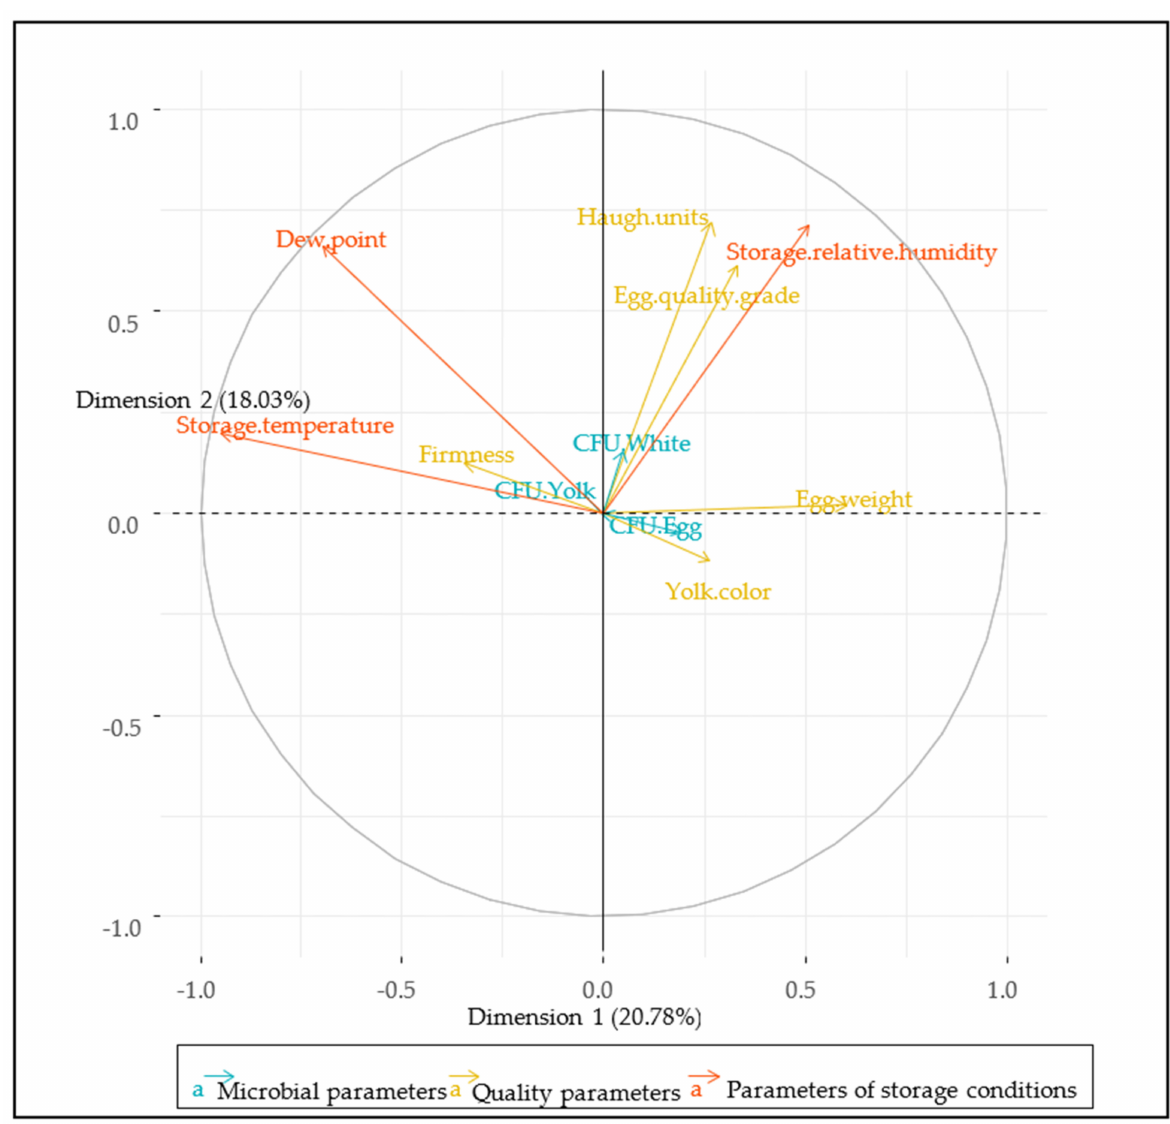
Figure 4. Correlation plot of variables in the first and second extracted dimension under different storage